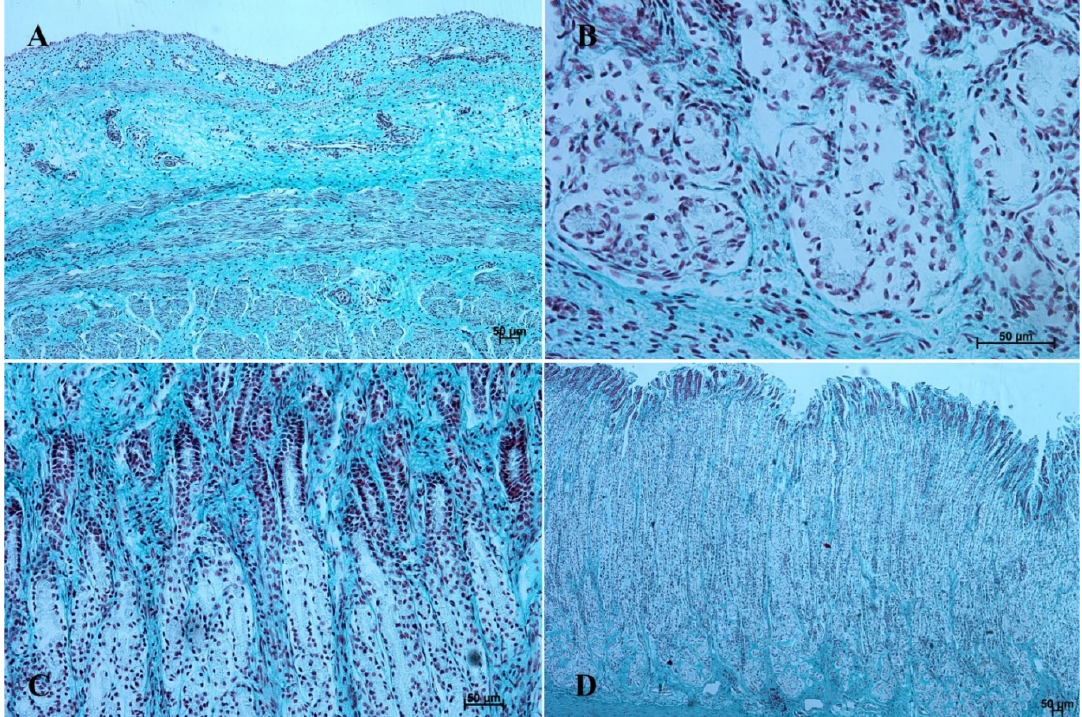
Figure 9. Histological structure of stomach mucosa in the fundic part (Masson-Goldner staining). ( A )—the first age group (20×); ( B )—the second age group (40×); ( C )—the third group (20×); ( D )—the reference adult group (5×).